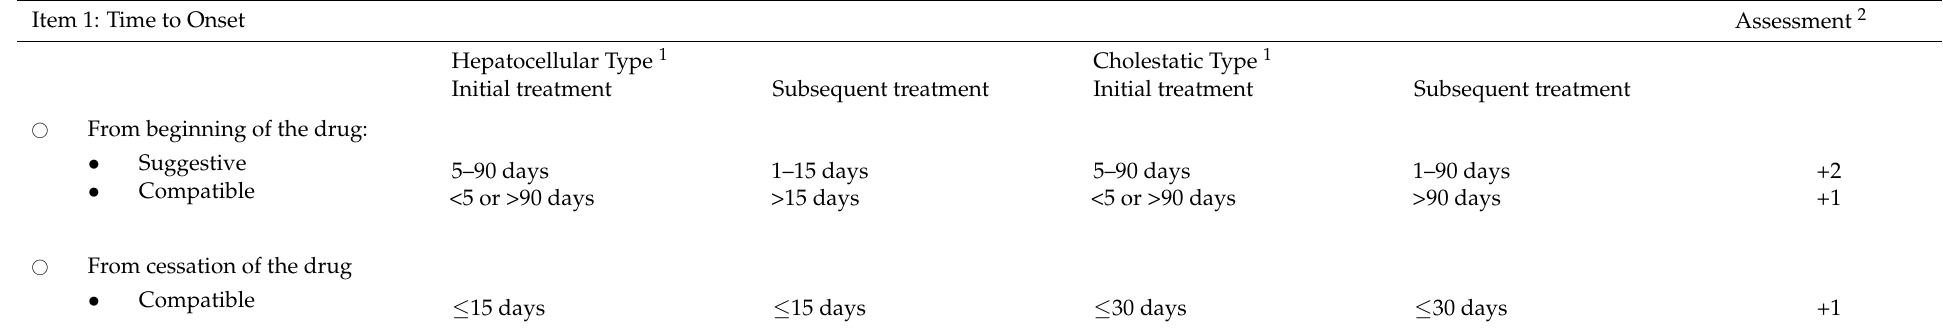
Table 1. RUCAM—drug causality